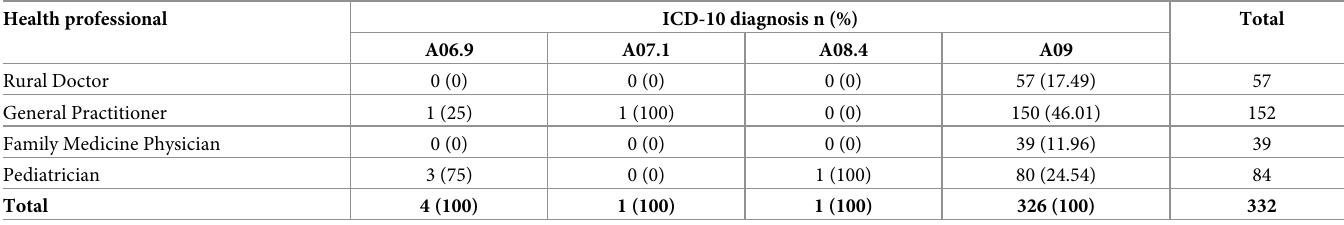
Table 2. Consultations of acute diarrhea by type of healthcare professional.